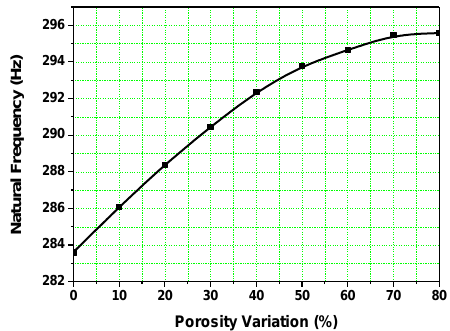
Figure 6. Effect of porosity on natural frequency.